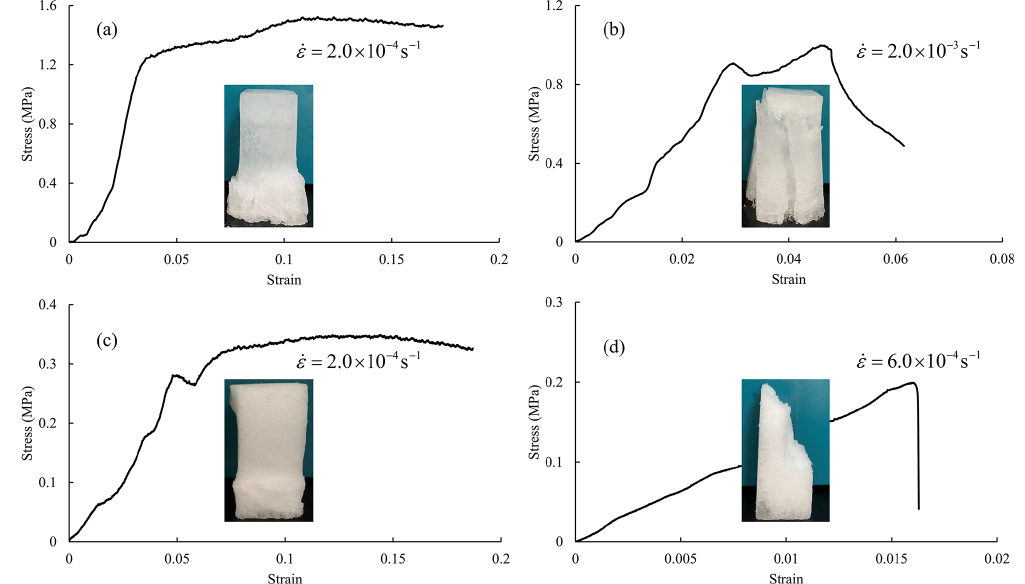
Figure 12. Typical stress–strain curves and failure modes of mixed ice samples (a) and (b) as well as of snow ice samples (c) and (d) under vertical loading direction.